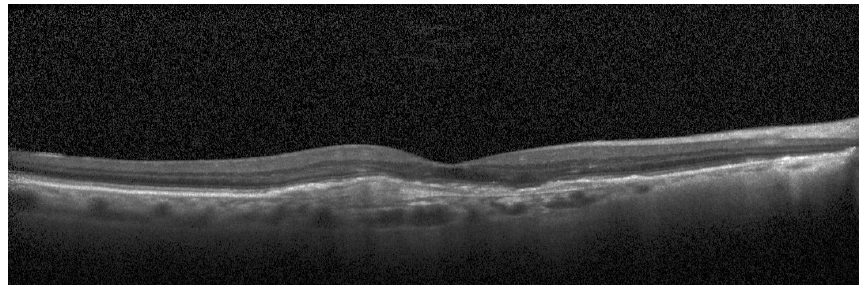
Figure 3. Sample OCT image.